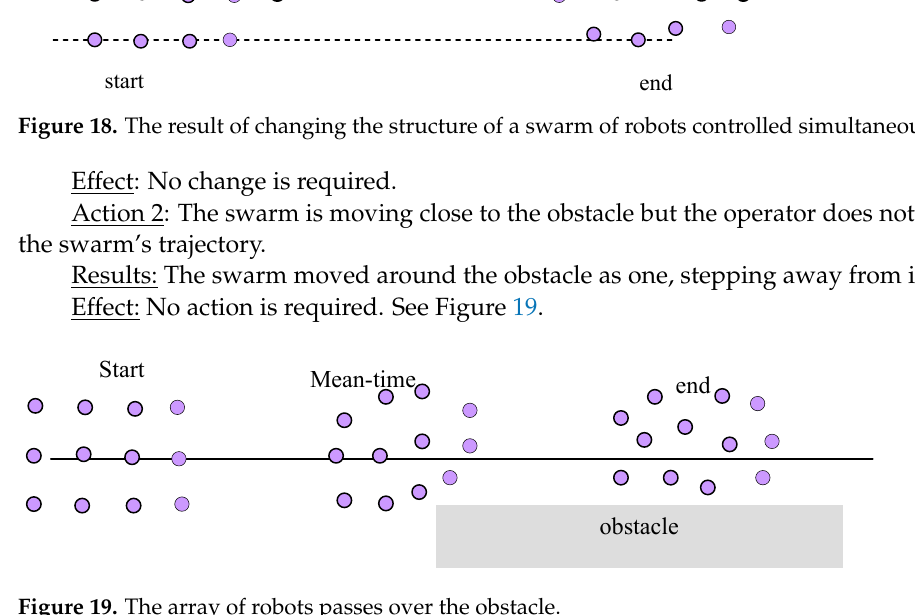
Figure 19. The array of robots passes over the obstacle.